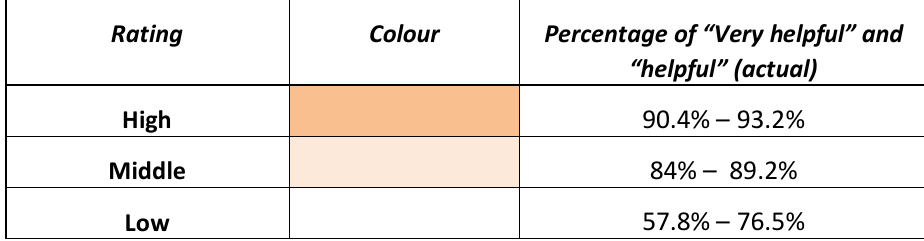
Table 18.1 : Scheme for the evaluated helpfulness of portal support for discovering and accessing datasets or collections of different types of data (“collection - level